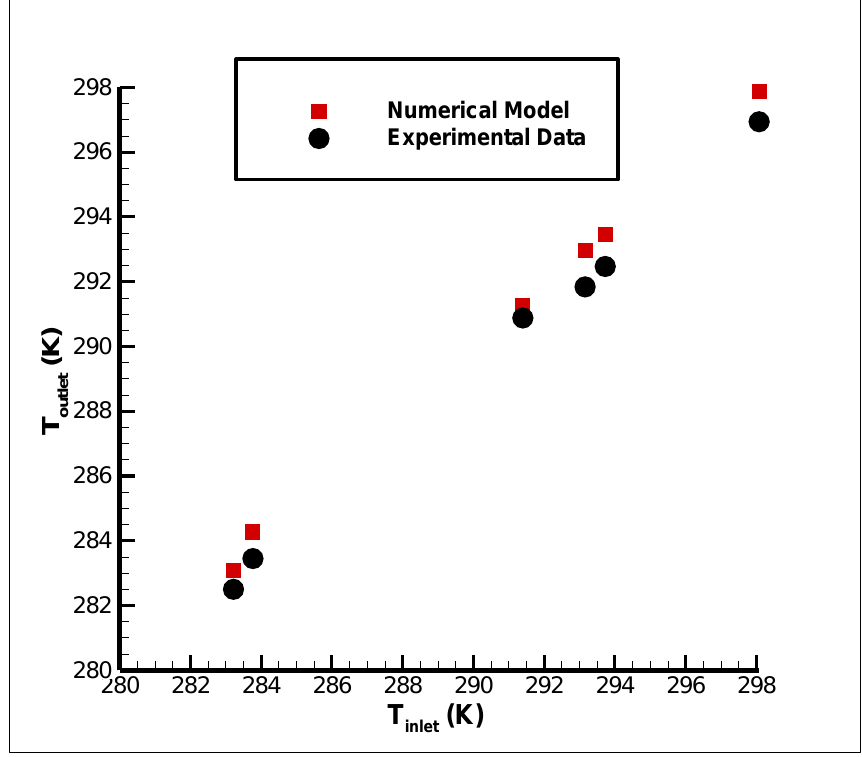
Figure 8. The comparison of experimental and numerical results.